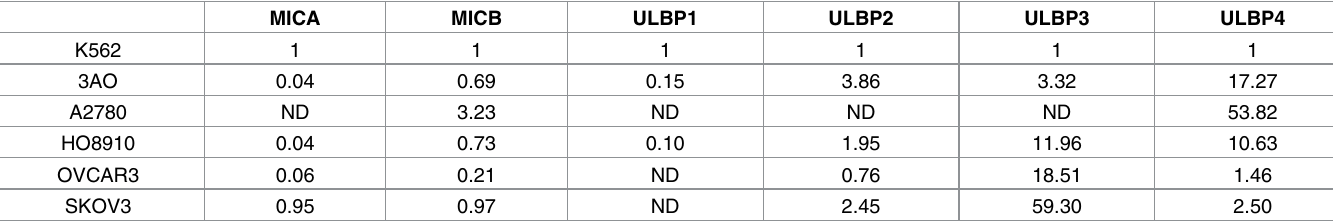
Table 4. Gene expressions of NKG2D ligands in ovarian cancer cell